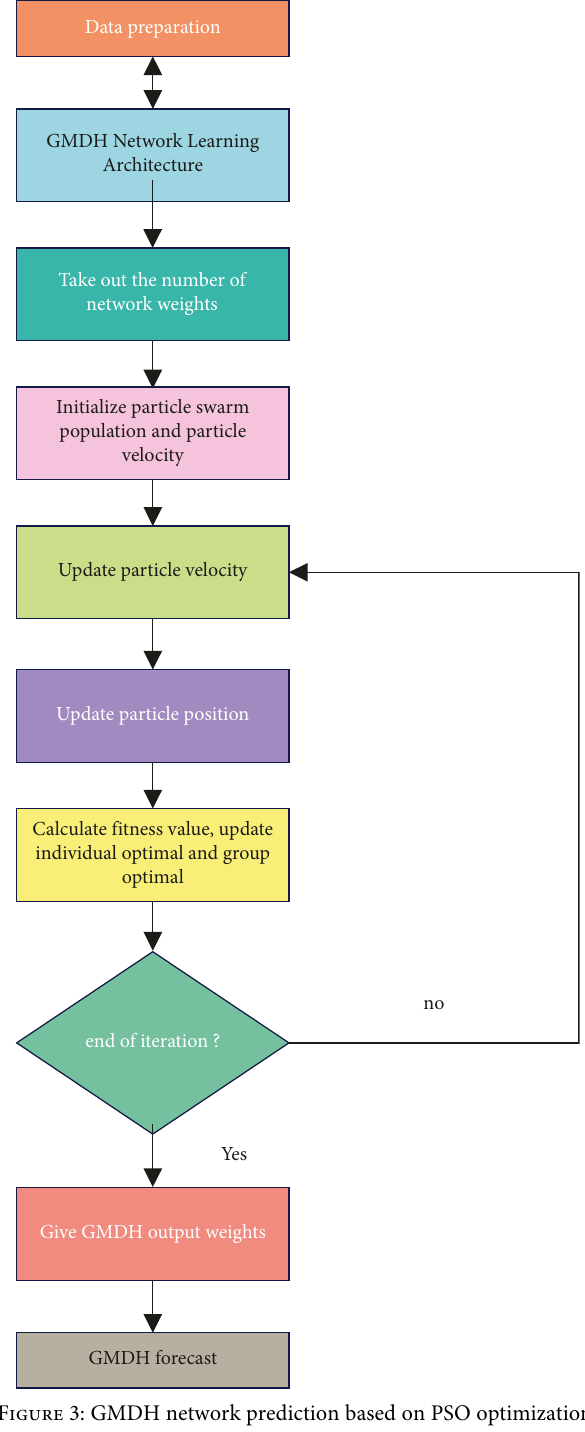
Figure 3: GMDH network prediction based on PSO